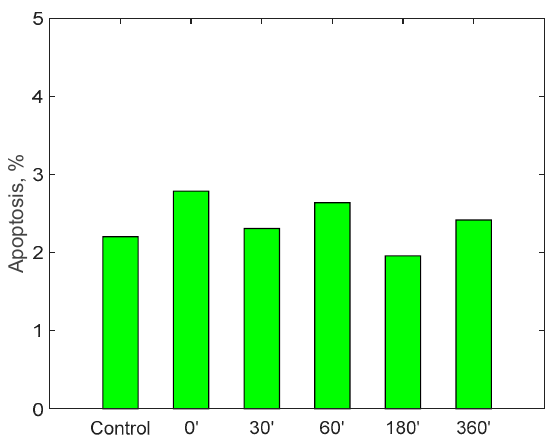
Figure 15. Apoptosis on monocytes cell line U937 after incubation with fluid circulated in the RAP for up to 360 minutes.